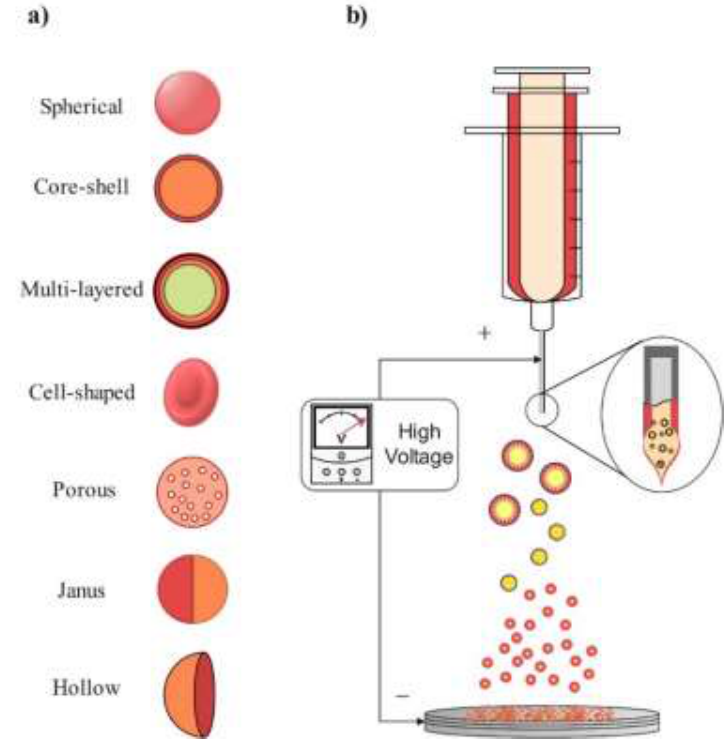
Figure 2: Schematic illustration of (a) various nanosphere structures produced by electrospray technique and (b) electrospray set up for fabrication of core-shell